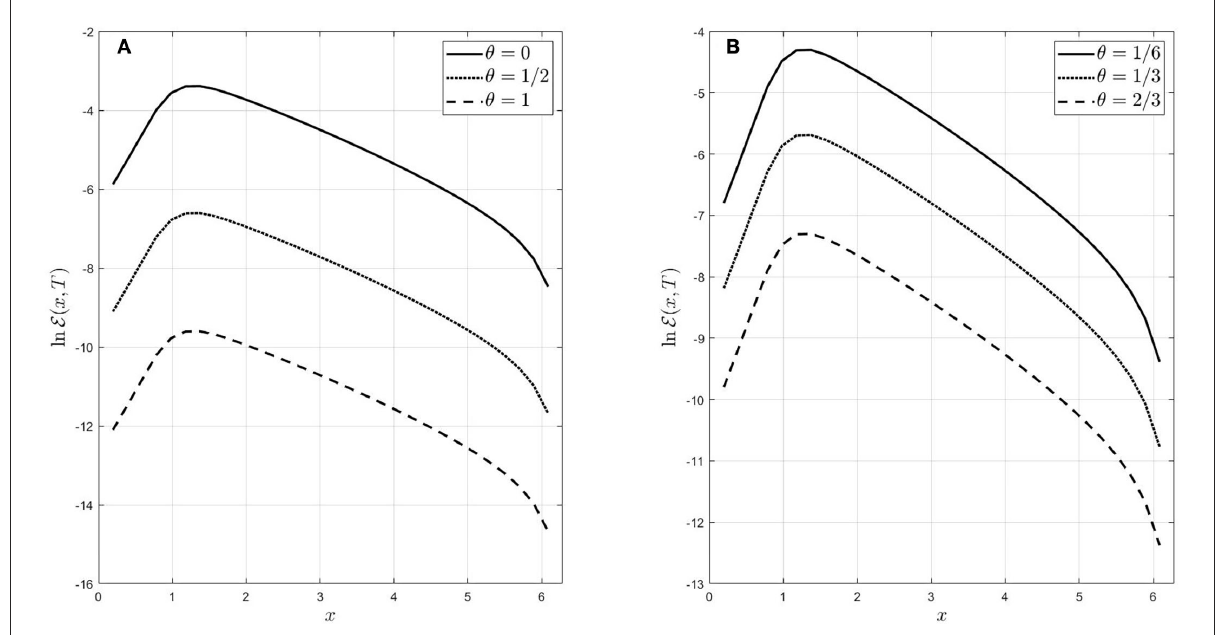
FIGURE3 (A,B) The order of absolute error ln E ( x , τ